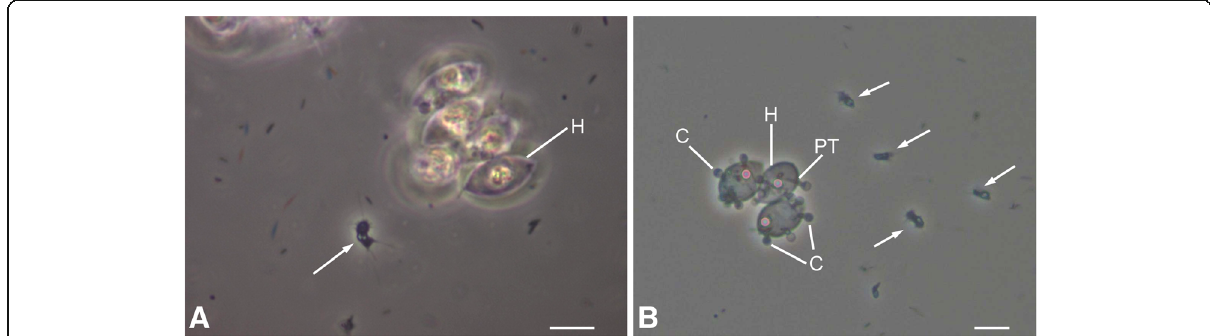
Fig. 1 Light microscopic images of Aphelidium protococcorum (FD 95), representative of Aphelidiaceae . a Motile zoospore (arrow) in vicinity of uninfected host (H) ( Scenedesmus ) cells. b Motile zoospores (arrows) and host cells to which zoospores have attached, encysted C and penetrated the host via a penetration tube (PT). Bars: A=5 μ m, B=10 μ